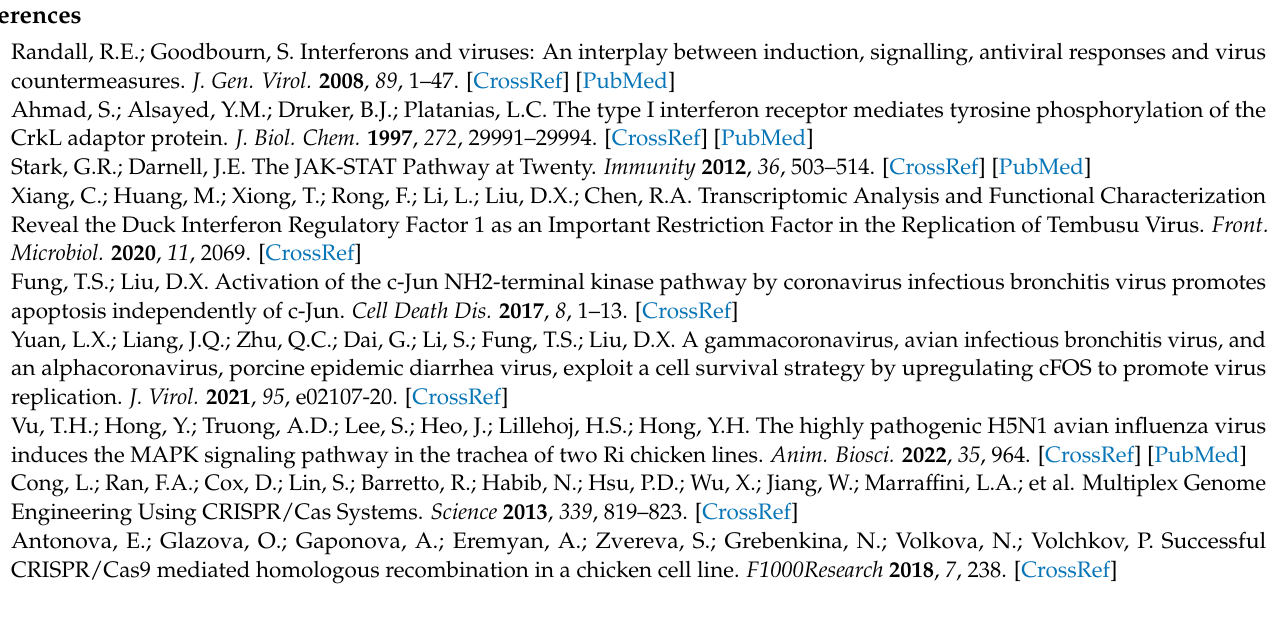
Figure S2: Validation of sgRNA knockout efficiency; Figure S3: 2-base deletion results in premature termination of IFNAR1 protein translation; Figure S4: Heatmap analysis of differentially expressed genes; Figure S5: Overexpression of IFNAR1 restores IFNAR1 function in KO IFNAR1